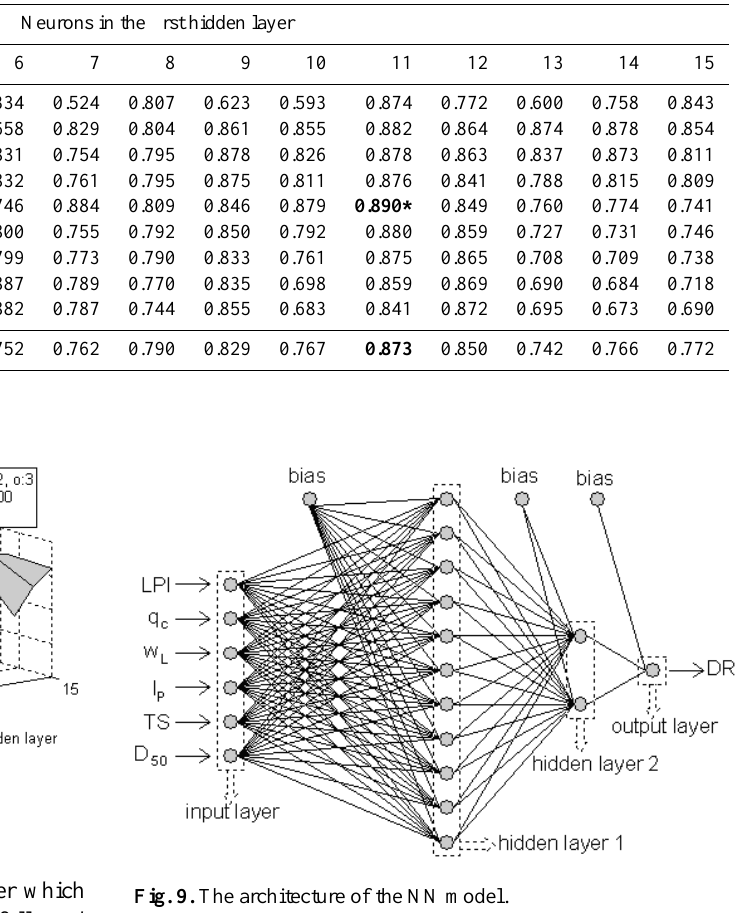
Table 5. Estimation of optimum network structure.